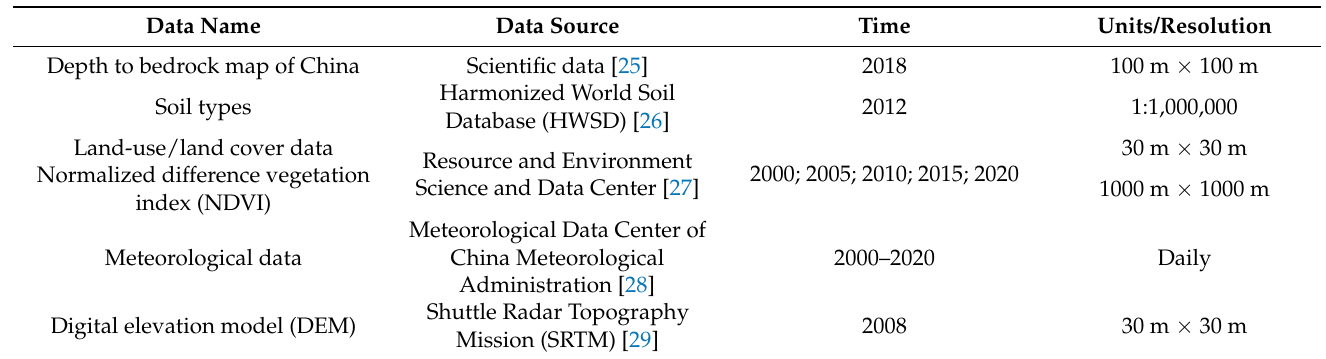
Table 1. Data description.